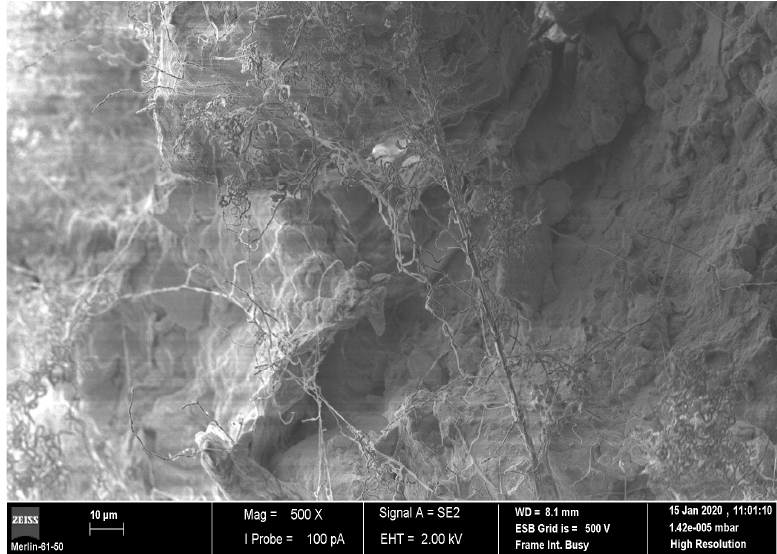
Figure 1. SEM image of a non-organic silty sand stabilized with 2% of XG.